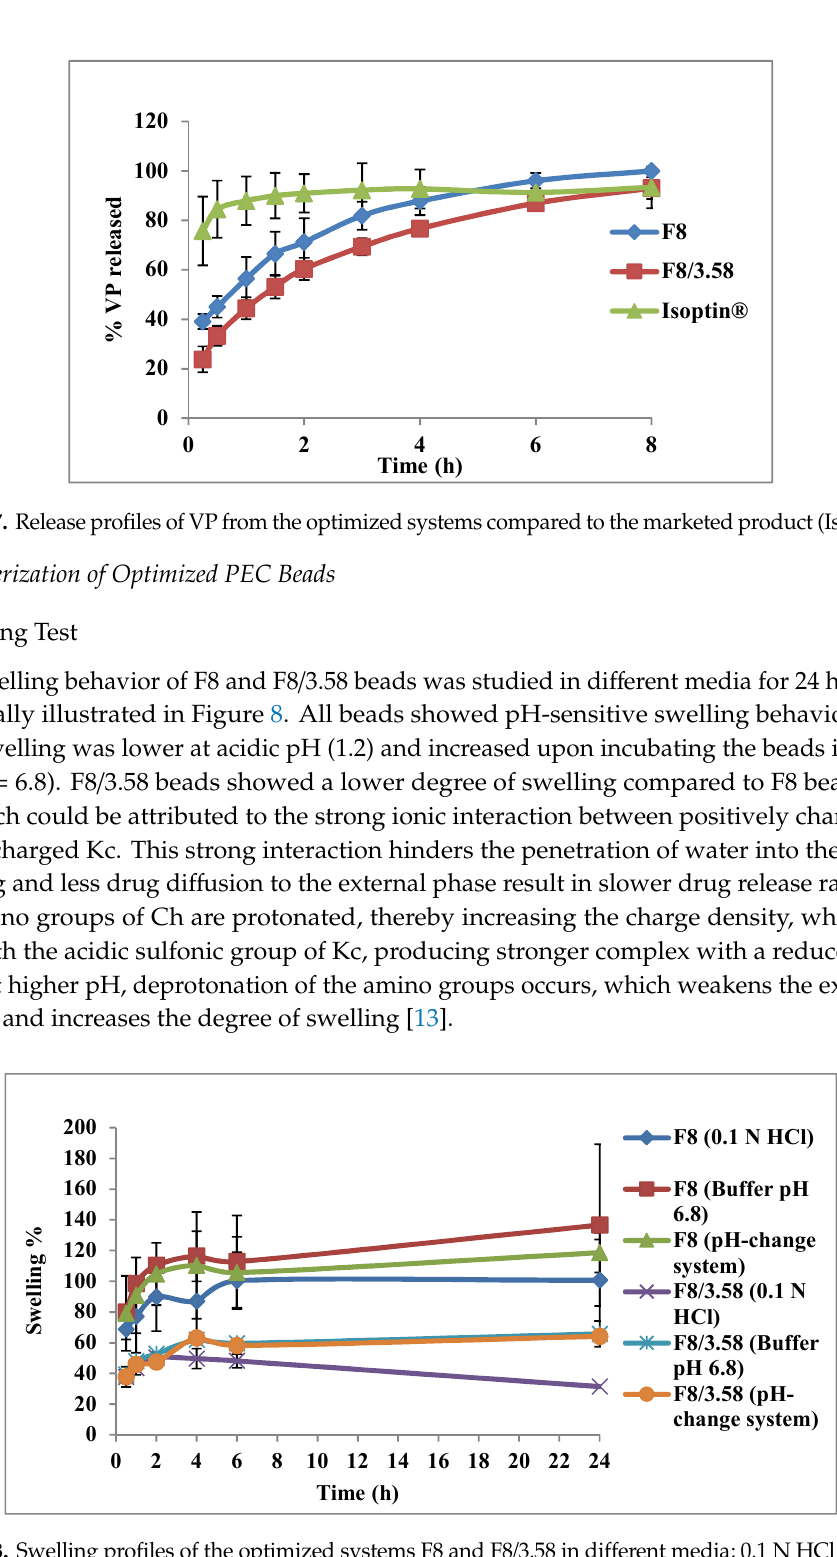
Figure 8. Swelling profiles of the optimized systems F8 and F8 / 3.58 in different media; 0.1 N HCl (pH 1.2), phosphate buffer (pH 6.8) and pH-change system (HCl for the first 2 h then phosphate buffer for 22